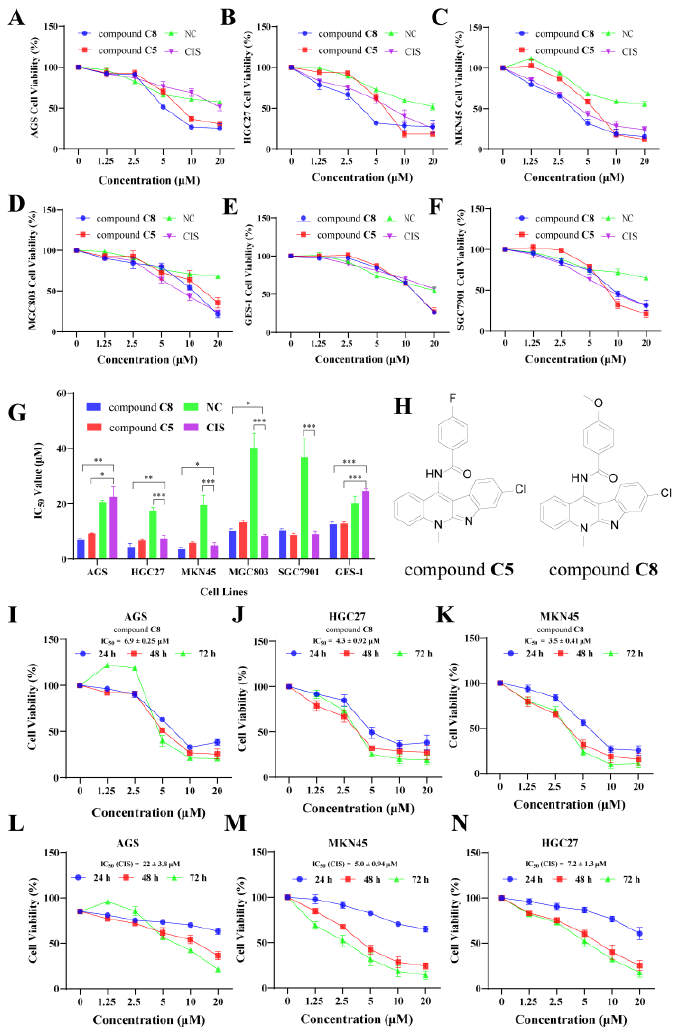
Figure 2. Cytotoxicity evaluation of neocryptolepine (NC), compounds C5 , C8, and CIS on gastric cancer cell lines. ( A – F ) The cytotoxic effects of NC, compound C5 , compound C8, and CIS at different concentrations on AGS, HGC27, MKN45, MGC803, GES-1, and SGC7901 cells, at 48 h, respectively. ( G ) IC 50 comparison of NC, compound C5 , compound C8, and CIS on gastric cancer cell lines at 48 h. ( H ) Chemical structure of compounds C5 and C8 . ( I – K ) The cytotoxic effects of compound C8 with different concentrations on AGS, HGC27, and MKN45 cells at 24 h, 48 h, and 72 h, respectively. ( L – N ) Cytotoxic effects of CIS at different concentrations on AGS, HGC27, and MKN45 cells at 24 h, 48 h, and 72 h. Values are shown as the means ± standard, n = 3. * p < 0.05, ** p < 0.01, *** p < 0.001 compared to negative DMSO control